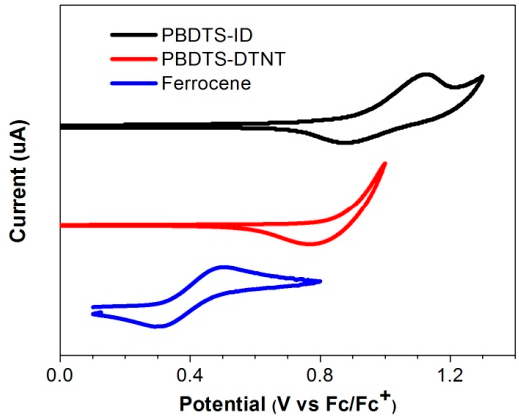
Figure 3. CV curves of the polymers PBDTS-ID and PBDTS-DTNT.